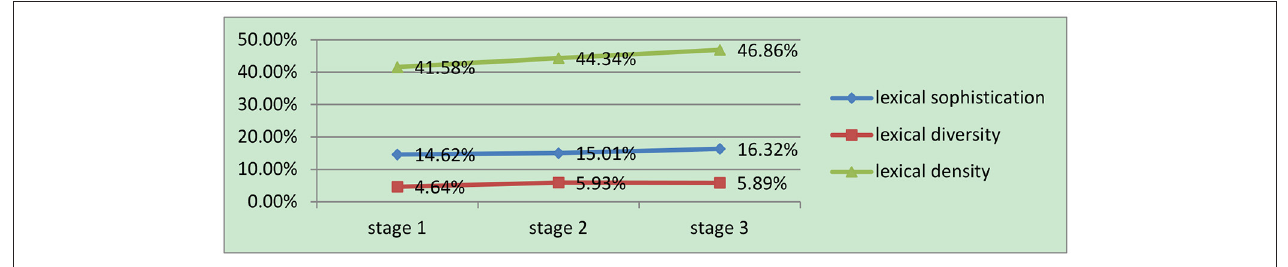
FIGURE 1 | The development of lexical richness in L3